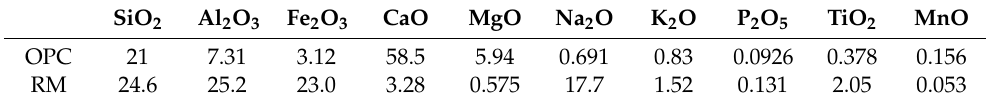
Table 1. Chemical compositions of red mud (RM) and Portland cement (OPC).